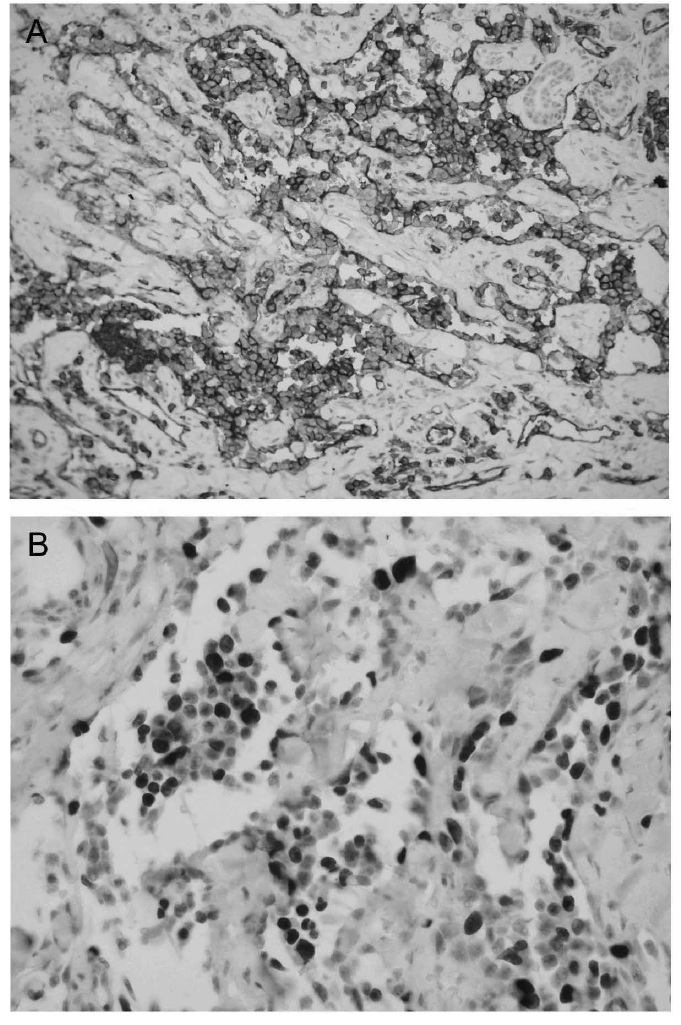
Fig. 3. The cutaneous angiosarcoma. (A) CD31-immunostained section; (B) p53-immunostained section showing strong nuclear staining.